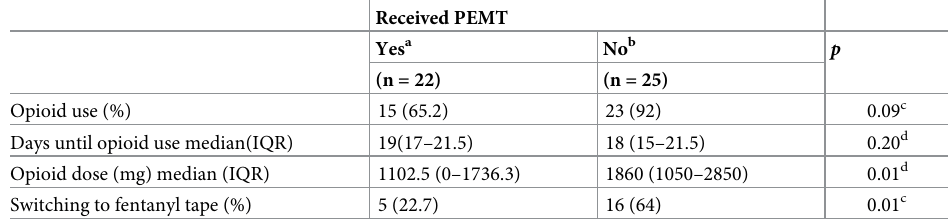
Table 3. Summary of data for patients receiving